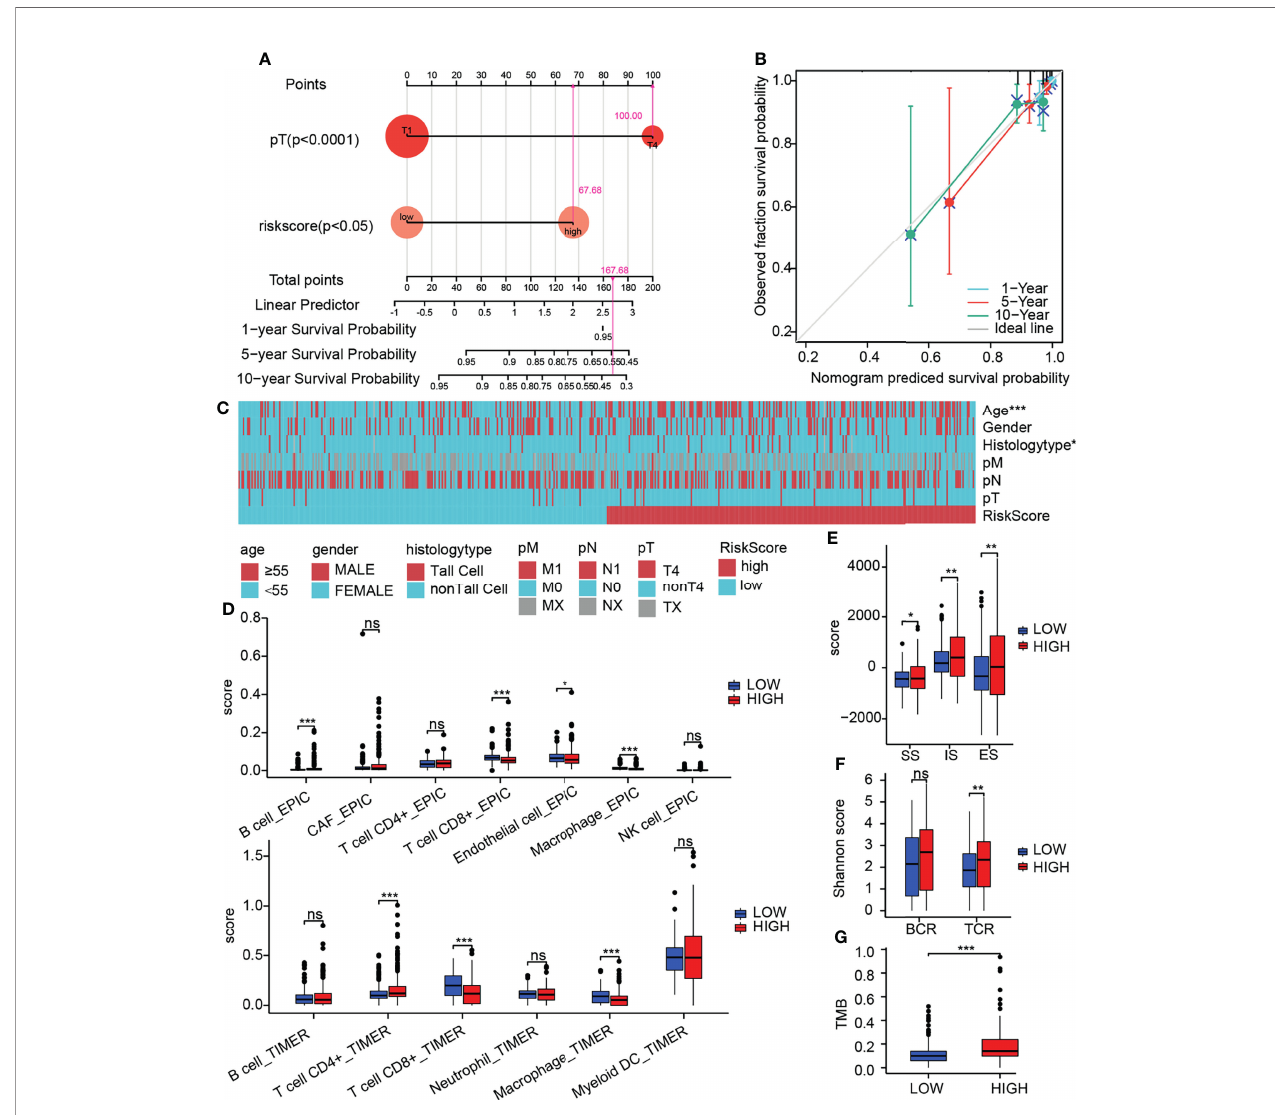
FIGURE 7 | Integrative analysis of prognostic model. (A) Nomogram quanti fi es clinical information and risk score. (B) Calibration curve to evaluate nomogram model. (C) Heatmap of the relationship between prognostic risk score and clinical information. (D) Relationship between prognostic risk score and immune cell in fi ltration (by TIMER and EPIC). (E) Relationship between prognostic risk score and immune score (by ESTIMATE). (F) Relationship between prognostic risk score and TMB. (G) Relationship between prognostic risk score and diversity of immune repertoire. ns, not signi fi cant; *p ≤ 0.05; **p ≤ 0.01; ***p ≤